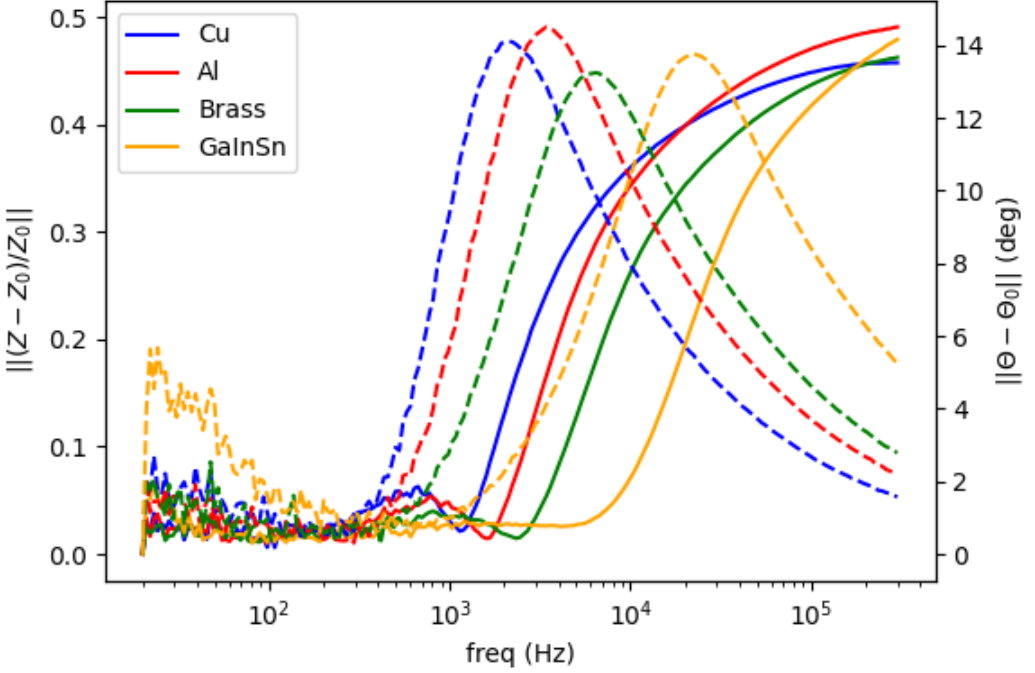
Figure 4. Spectral plot for metallic samples (conductivity variations). Solid line for amplitude ratio (left vertical axis); dashed line for phase difference (right vertical axis).